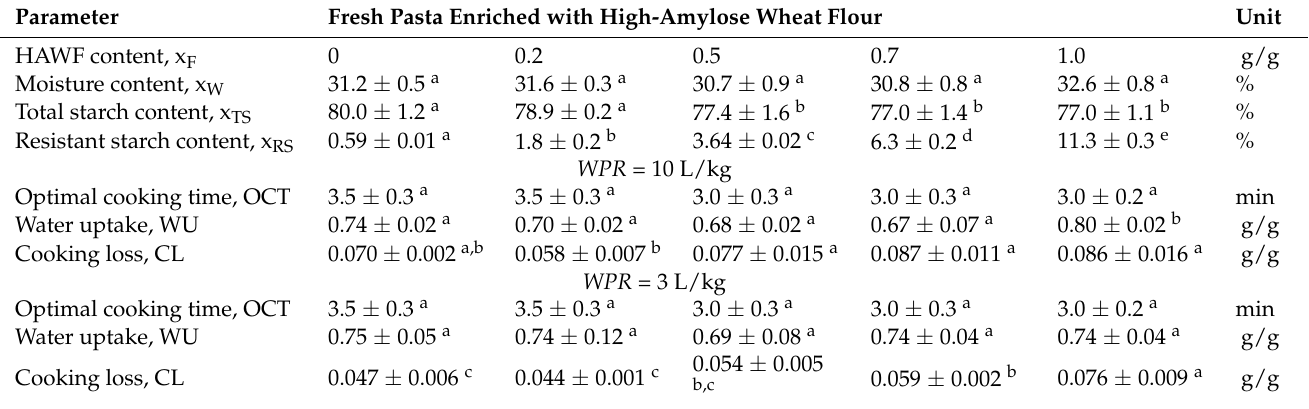
Table 2. Effect of the percentage (x F ) of high-amylose wheat flour (HAWF) in the flour mixture used to prepare fresh pasta samples on the main biochemical and technological properties of the pasta when cooked at different water-to-pasta ratios